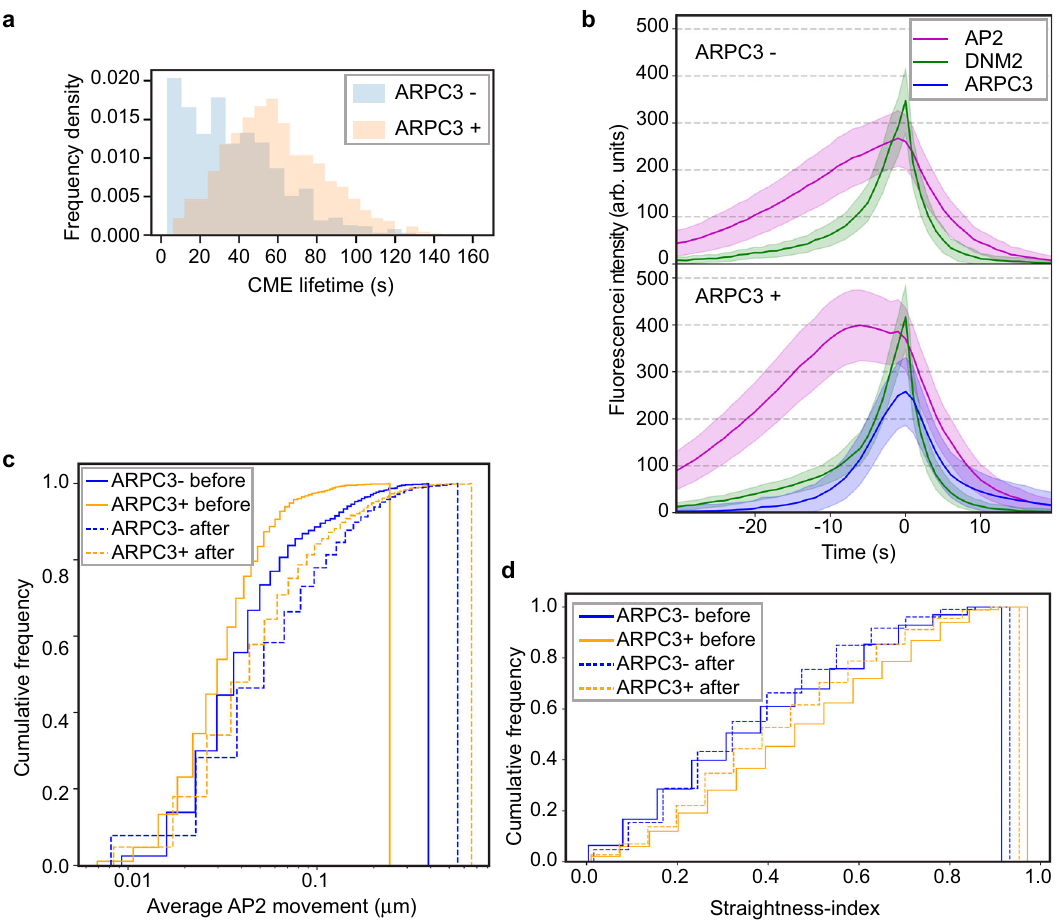
Fig. 5 Actin positive CME sites show distinct dynamics. a Histograms of ARPC3 negative (blue) and positive (orange) CME lifetimes. CME lifetime is measured from the fi rst frame of the AP2 signal to the presumed scission time (the peak of DNM2 signal). ARPC3 positive CME events have longer lifetimes. p-value from two-sided Welch ’ s t-test: 2.11e-76. b Averaged intensity vs time plots of ARPC3 negative (top) and positive (bottom) CME sites in ADA cells. Events were aligned to the frames showing the maximum DNM2 intensity. Error bar: ¼ standard deviation. c Lateral motility of ARPC3 negative (blue) and positive (yellow) CME sites before (solid line) and after (dashed line) vesicle scission. ARPC3 positive CME sites move slower than ARPC3 negative ones. p-value from two-sided Kolmogorov-Smirnov test: ARPC3 + before vs ARPC3- before: 1.27e-14, ARPC3 + after vs ARPC3- after: 5.18e-08. d Straightness-index of ARPC3 negative (blue) and positive (yellow) CME sites before (solid line) and after (dashed line) scission. The straightness-index is de fi ned by the ratio between the sum of frame-to-frame distances to the end-to-end distance of a single event ’ s trajectory, where a perfectly straight- lined trajectory would have an index of 1. APRC3 positive CME sites move with a more straight trajectory. p-value from two-sided Kolmogorov – Smirnov test: ARPC3 + before vs ARPC3- before: 1.07e-11, ARPC3 + after vs ARPC3- after: 2.06e-6. a – d ARPC3 -: N = 840, ARPC3 + : N = 1,385. a , c , d Source data are provided in the Source Data fi